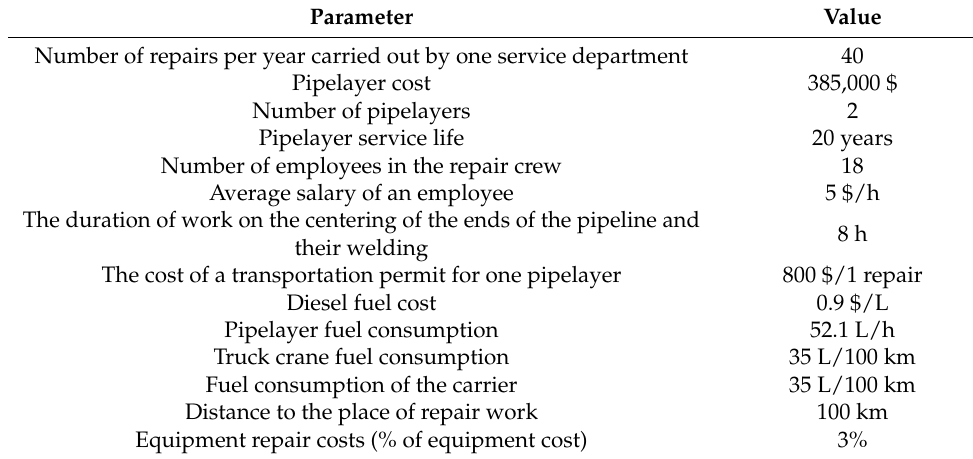
Table 6. Initial data for calculating the annual financial costs for repair work using pipelayers. Parameter Value Number of repairs per year carried out by one service department 40